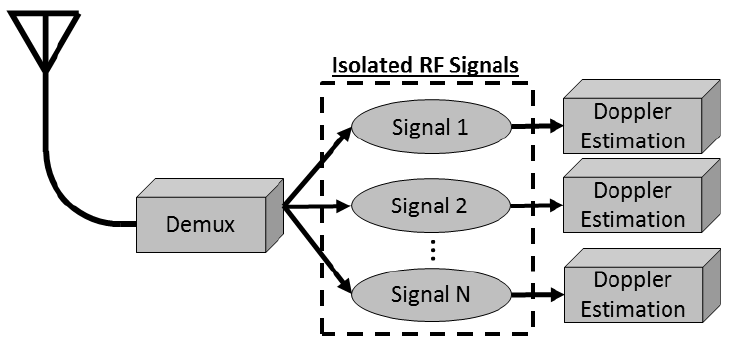
Figure 4. Flowchart of RF sensor processing to isolate and extract Doppler